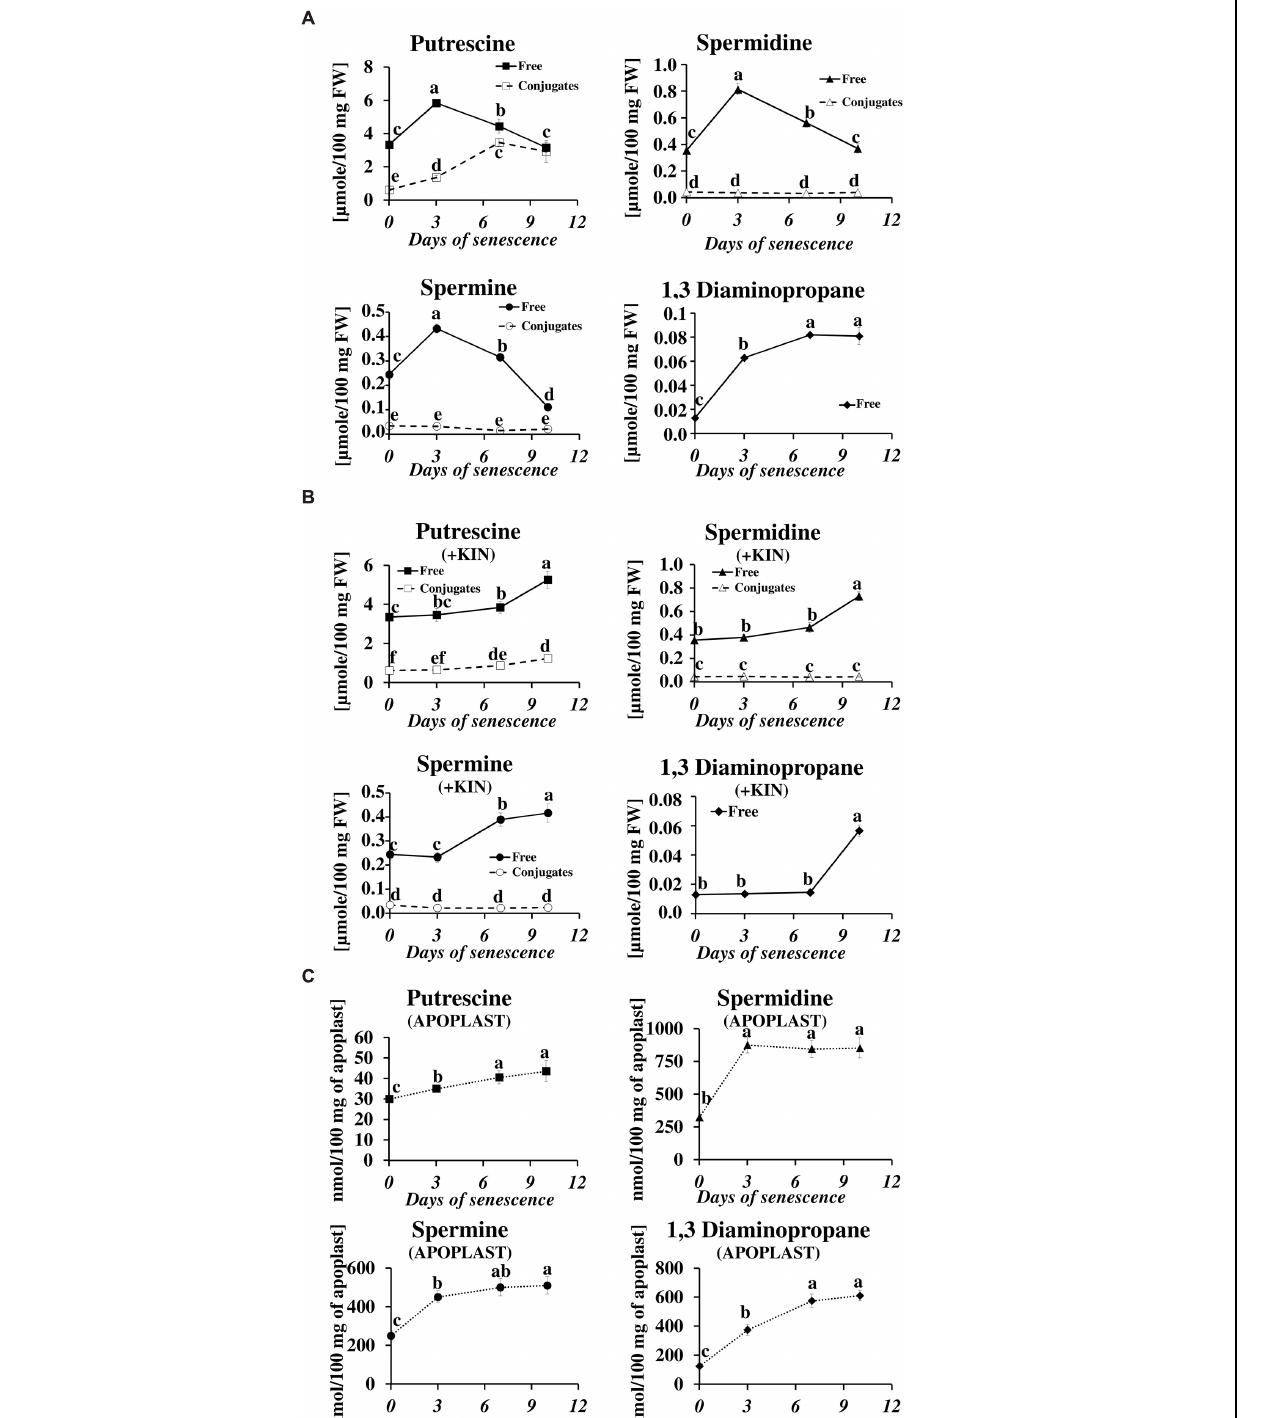
Frontiers in Plant Science | www.frontiersin.org